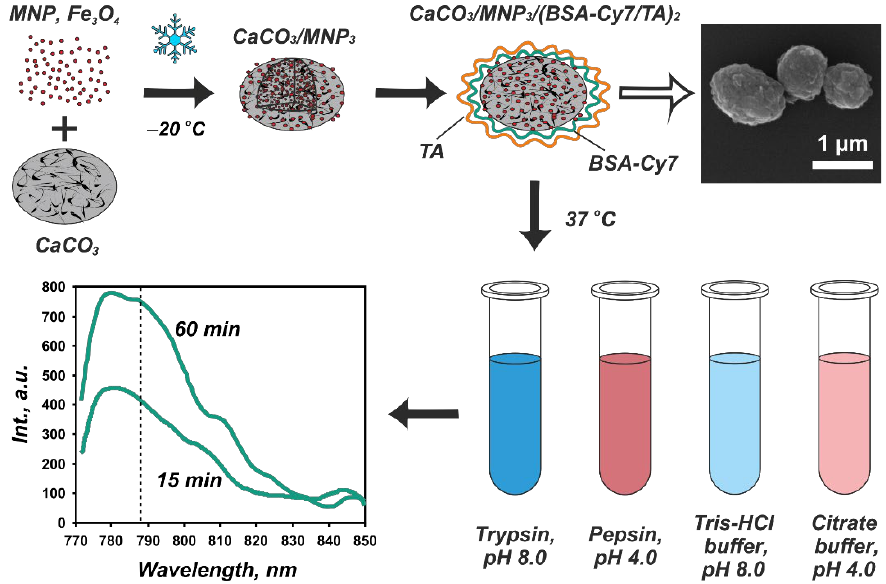
Figure 1. Scheme of the experiment on the enzymatic degradation of the protein–tannin core–shell carries including the stage of CaCO 3 /MNP 3 /(BSA-Cy7/TA) 2 structures formation (with the corresponding SEM image) as well as their incubation in enzyme solutions followed by spectrophotometric